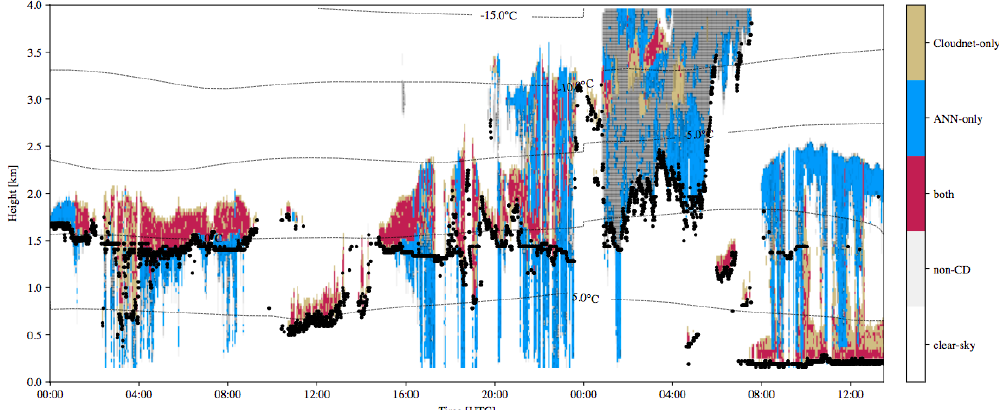
Figure A2. Zoom of comparison of cloud droplet detection of Cloudnet and ANN (using linear-1 thresholds) from 0 to 4km altitude for the 17–18 November 2014 case study in Cabauw, Netherlands. Black dots indicate ceilometer first cloud base height.